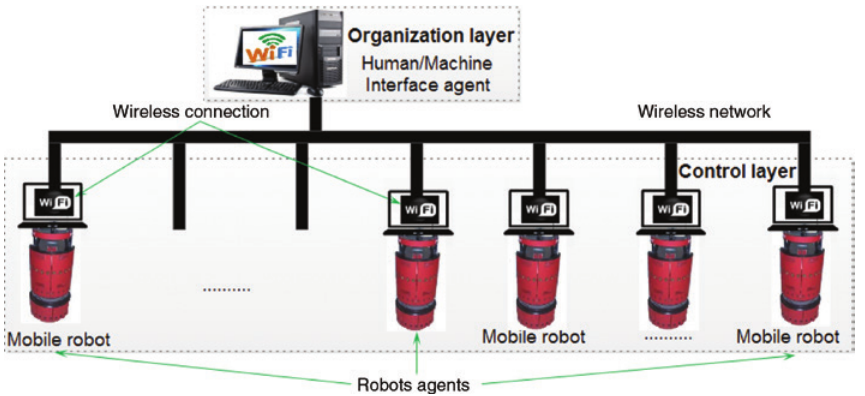
Figure 2: Overview of the Proposed Distributed Multi-agent Architecture for Mobile Robot Team